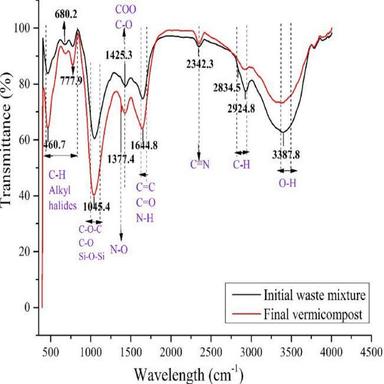
FT-IR spectra of the pre-composted waste mixture and final vermicompost.